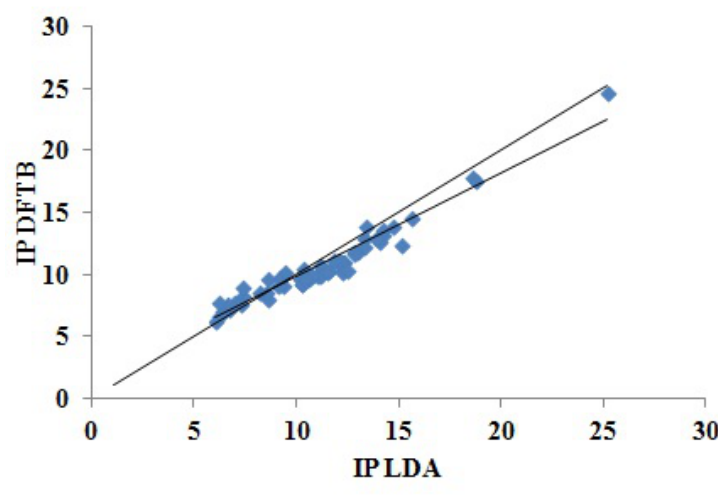
Figure 6. Correlation plot for DFTB versus LDA “Koopmans’ theorem IPs.” The units for both axes are